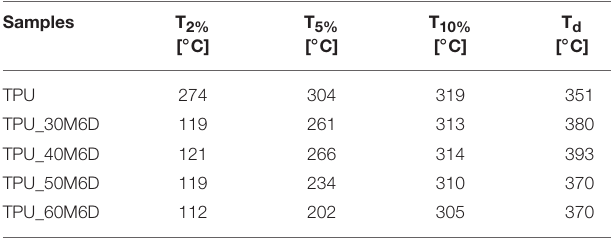
FIGURE 4 | Thermogravimetric curves of neat TPU, M6D capsules and their relative blends. (A) Residual mass and (B) derivative of the mass loss as a function of the temperature.